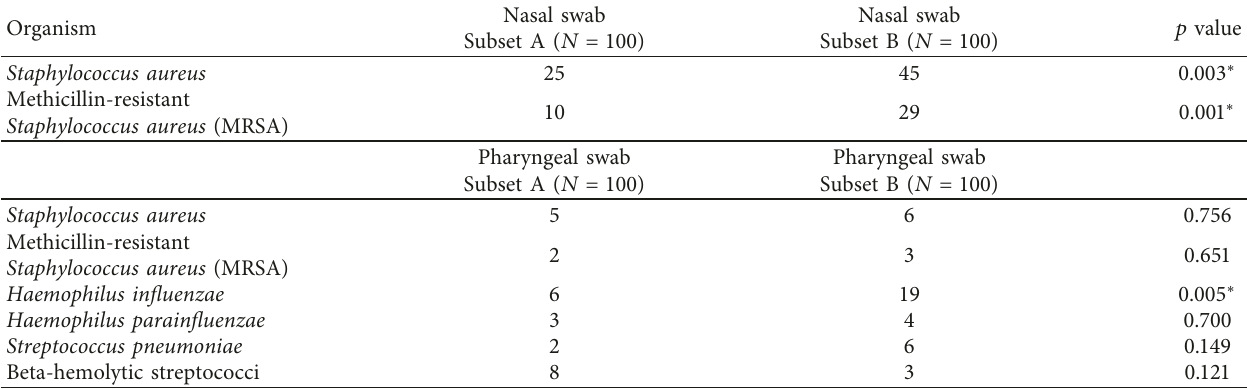
Table 2: Distribution of bacterial isolates from nasal and pharyngeal